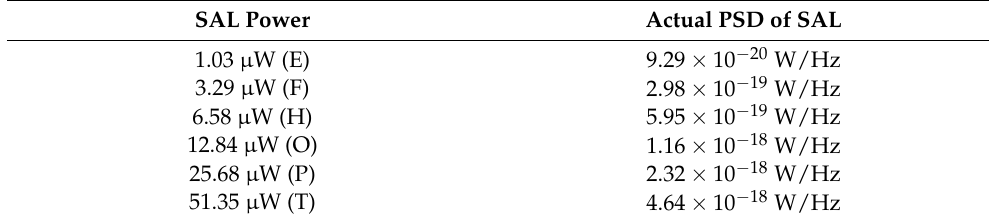
Table 4. SAL power, actual PSD of SAL (non-coherent).